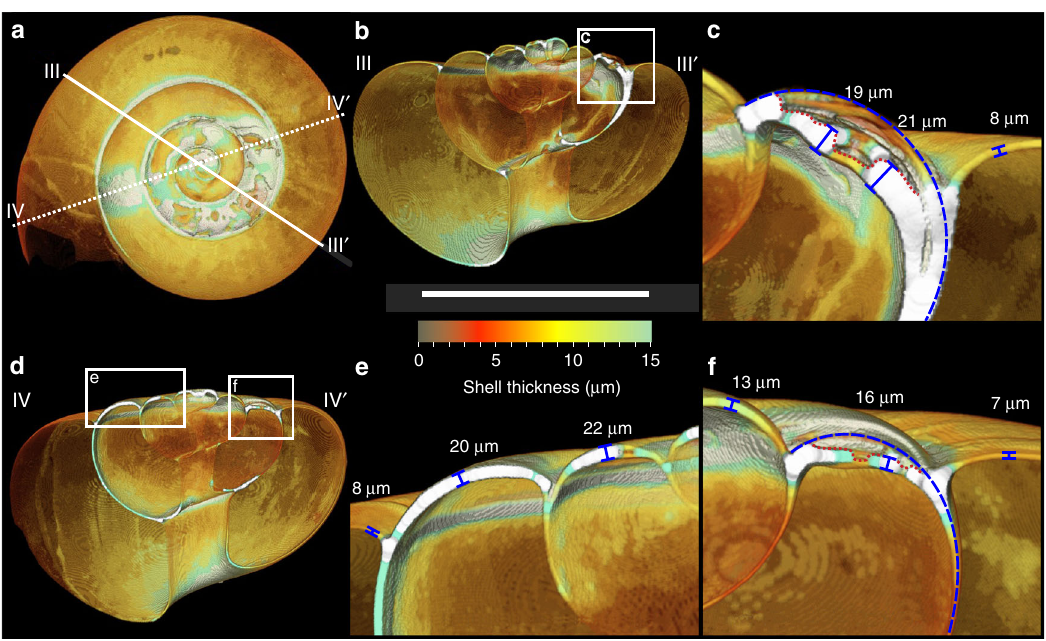
Fig. 3 Analysis of cross-sections to determine the extent of surface damage/dissolution and repair calci fi cation. a CT-scan thickness map; b cross-section along plane III-III ’ shown in a ; c zoom-in on area indicated in b ; d cross-section along plane IV – IV ’ shown in a ; d and e zoom-ins on areas indicated in d . White scale bar represents 1 mm. The shell thickness colour scale is indicated within the range 0 – 15 μ m. Shell exceeding a thickness of 15 μ m appears white. Point thickness measurements are indicated by blue barred lines (perpendicular to the outer surface). In c and f , the blue dashed line indicates the position that the original shell surface would have occupied prior to damage, based on the pro fi le of the undamaged shell of the same whorl in the background. The red dotted line indicates the current outer surface of the shell along the plane of the